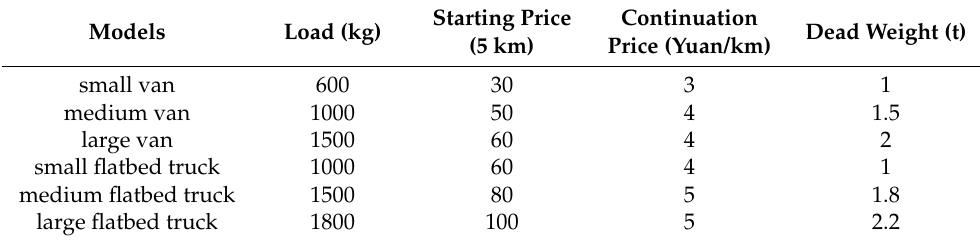
Table 2. Freight booking operation pricing